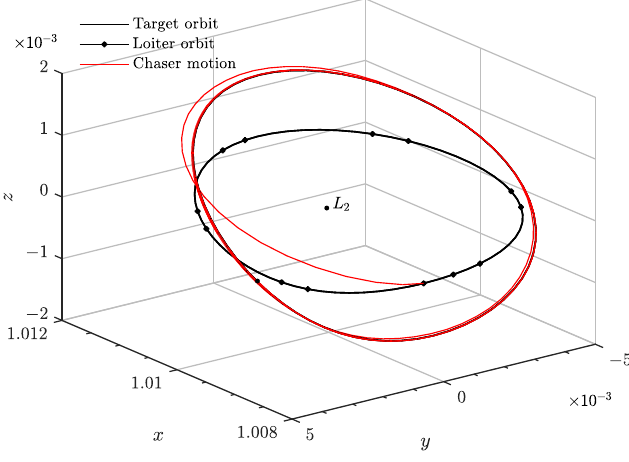
Figure 18. Trajectory of the JWST servicing spacecraft for the complete mission